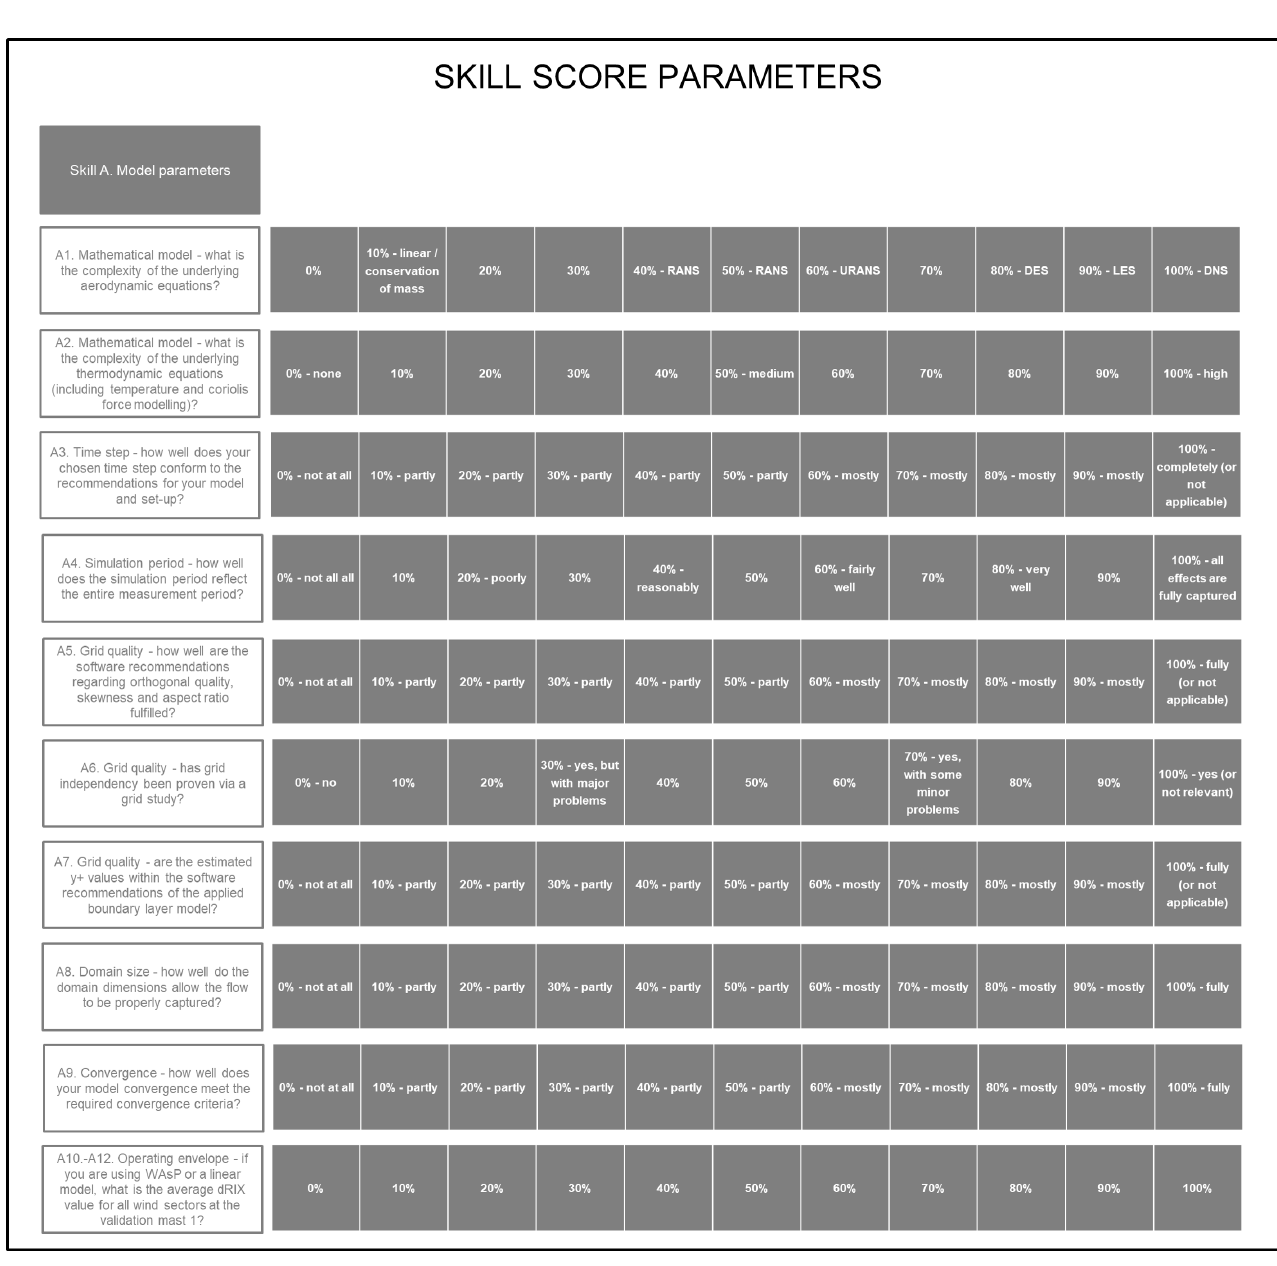
Figure A1. Scales assigned to each skill parameter (Skill